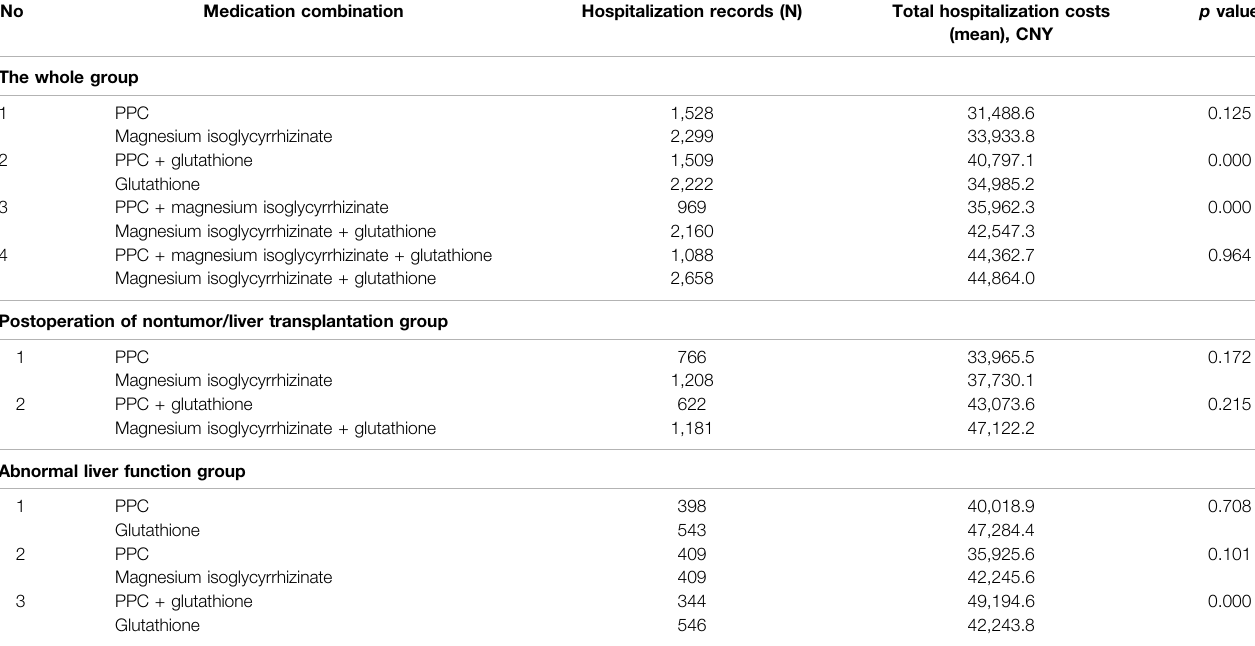
TABLE 5 | Cost minimization analysis in phase Ⅲ